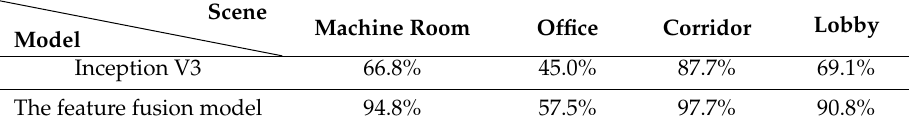
Table 3. Prediction result for each